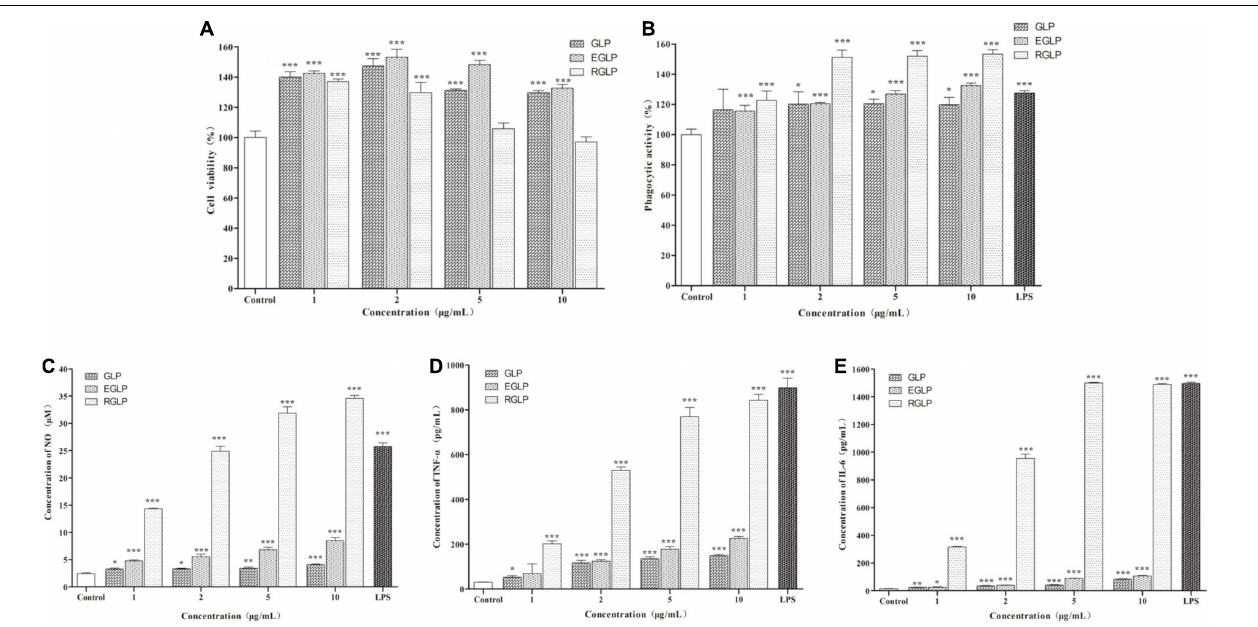
FIGURE 2 | The effect of polysaccharides on cell viability (A) , phagocytic ability (B) , NO (C) , TNF- α (D) , and IL-6 (E) of RAW 264.7 cells. ***Statistically significant at P < 0.001. **Statistically significant at P < 0.01. *Statistically significant at P <